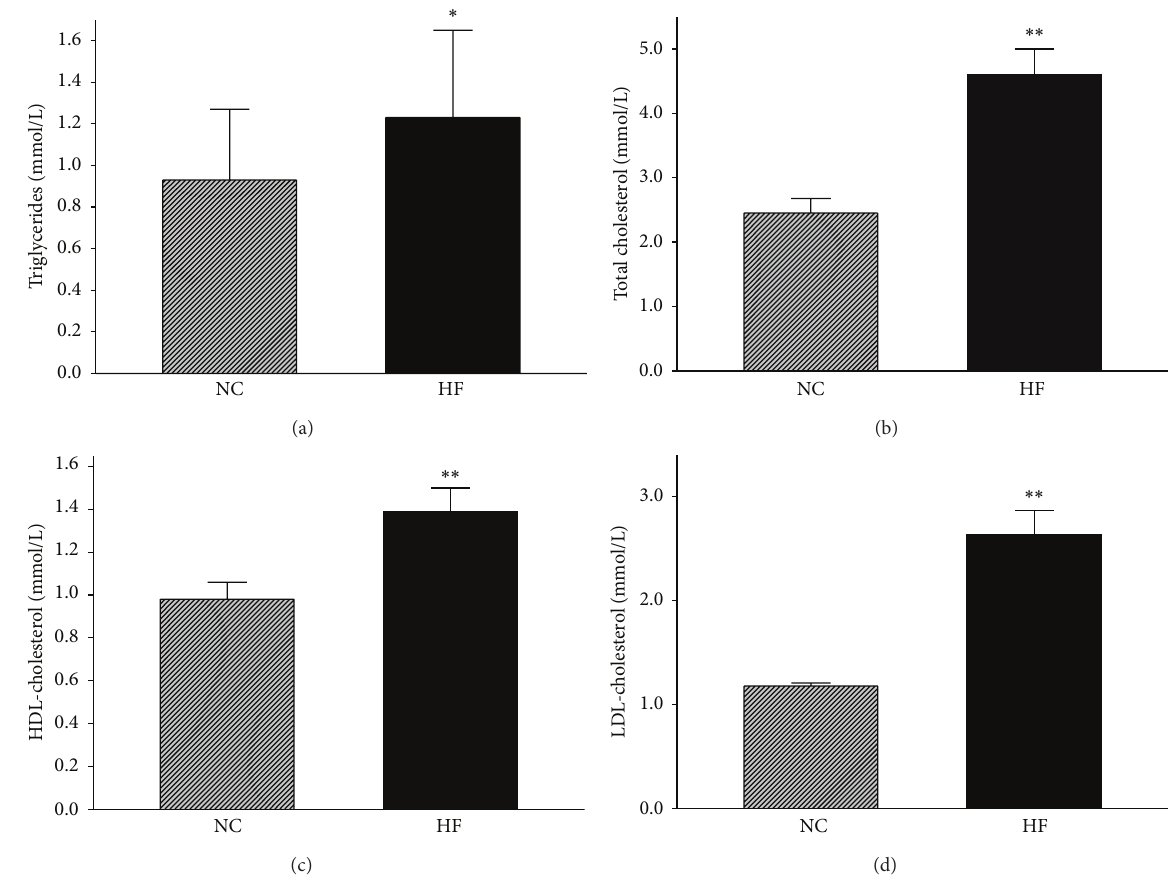
Figure 1: Serum lipids: TG (a), TC (b), HDL-C (c), and LDL-C (d). NC and HF, abbreviations for “normal diet” and “high-fat diet,” represent the control and HFD-fed groups, respectively. Data are presented as the mean ± SE, 𝑛 = 15 mice/group, ∗ 𝑃 < 0.05 , and ∗∗ 𝑃 < 0.01